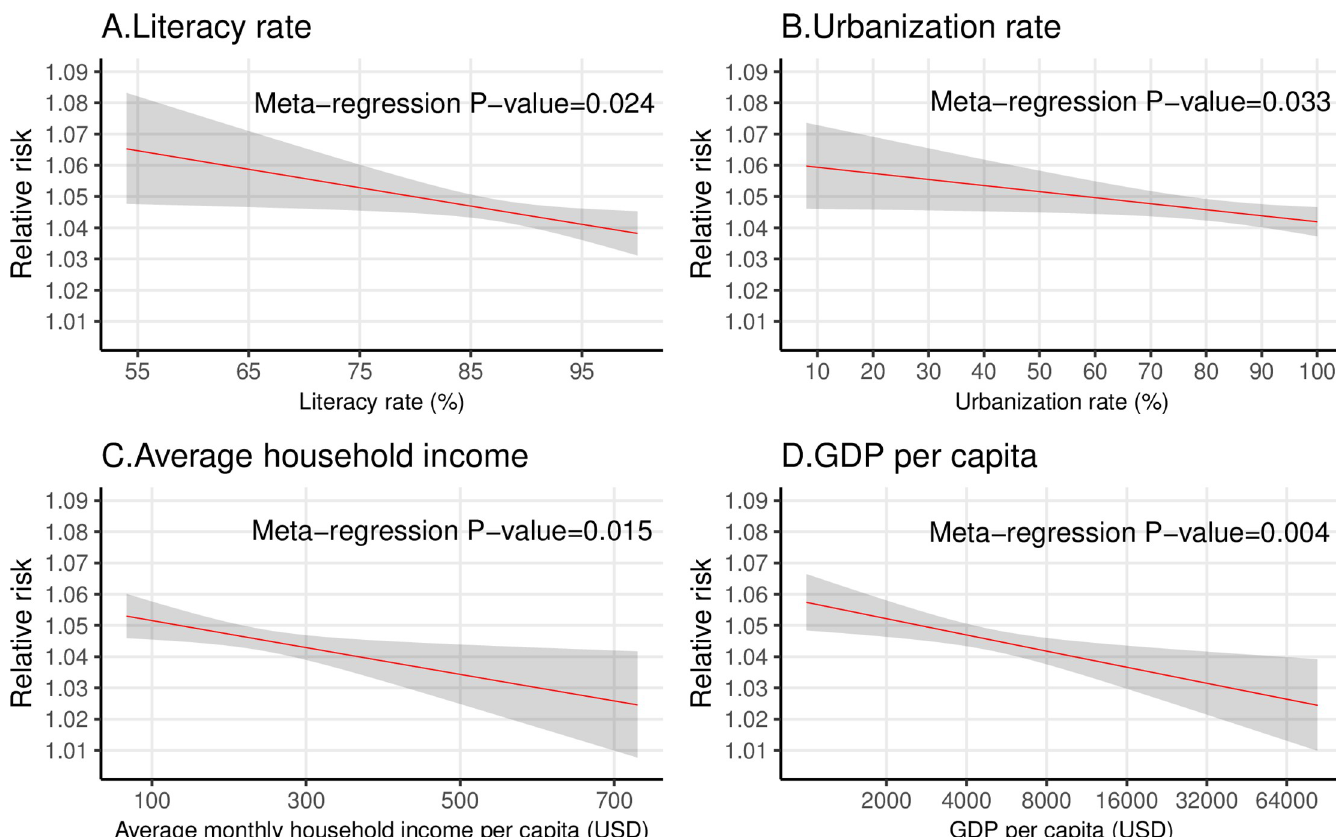
Fig 5. The relationship between city-level socioeconomic factors and the magnitude of heat–hospitalization association among 1,814 cities, adjusting for potential confounders. Literacy rate (A), urbanization rate (B), household income (C), and GDP per capita (D). The RR represents the association between heat exposure (for every 5˚C increase in daily mean temperature) and hospitalization during lag 0–7 days. The shadowed area represents the 95% confidence interval. The relationships between RR and the 4 socioeconomic indicators were fitted separately by meta-regression, adjusting for city-specific mean temperature, temperature range, and the ratio of elderly population ( � 60 years) and young population (0–19 years). The RRs were estimated as the values when city-specific mean temperature, temperature range, and the ratio of elderly population and young population were at the average level of the 1,814 cities. The x -axis of (D) is on the log scale, because we added log(GDP per capita) rather than GDP per capita to the meta-regression model. GDP, gross domestic product; RR, relative risk; USD, United States dollars.